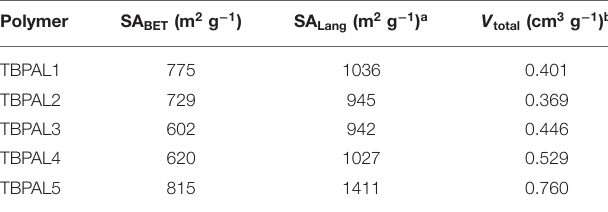
TABLE 1 | Pore properties of